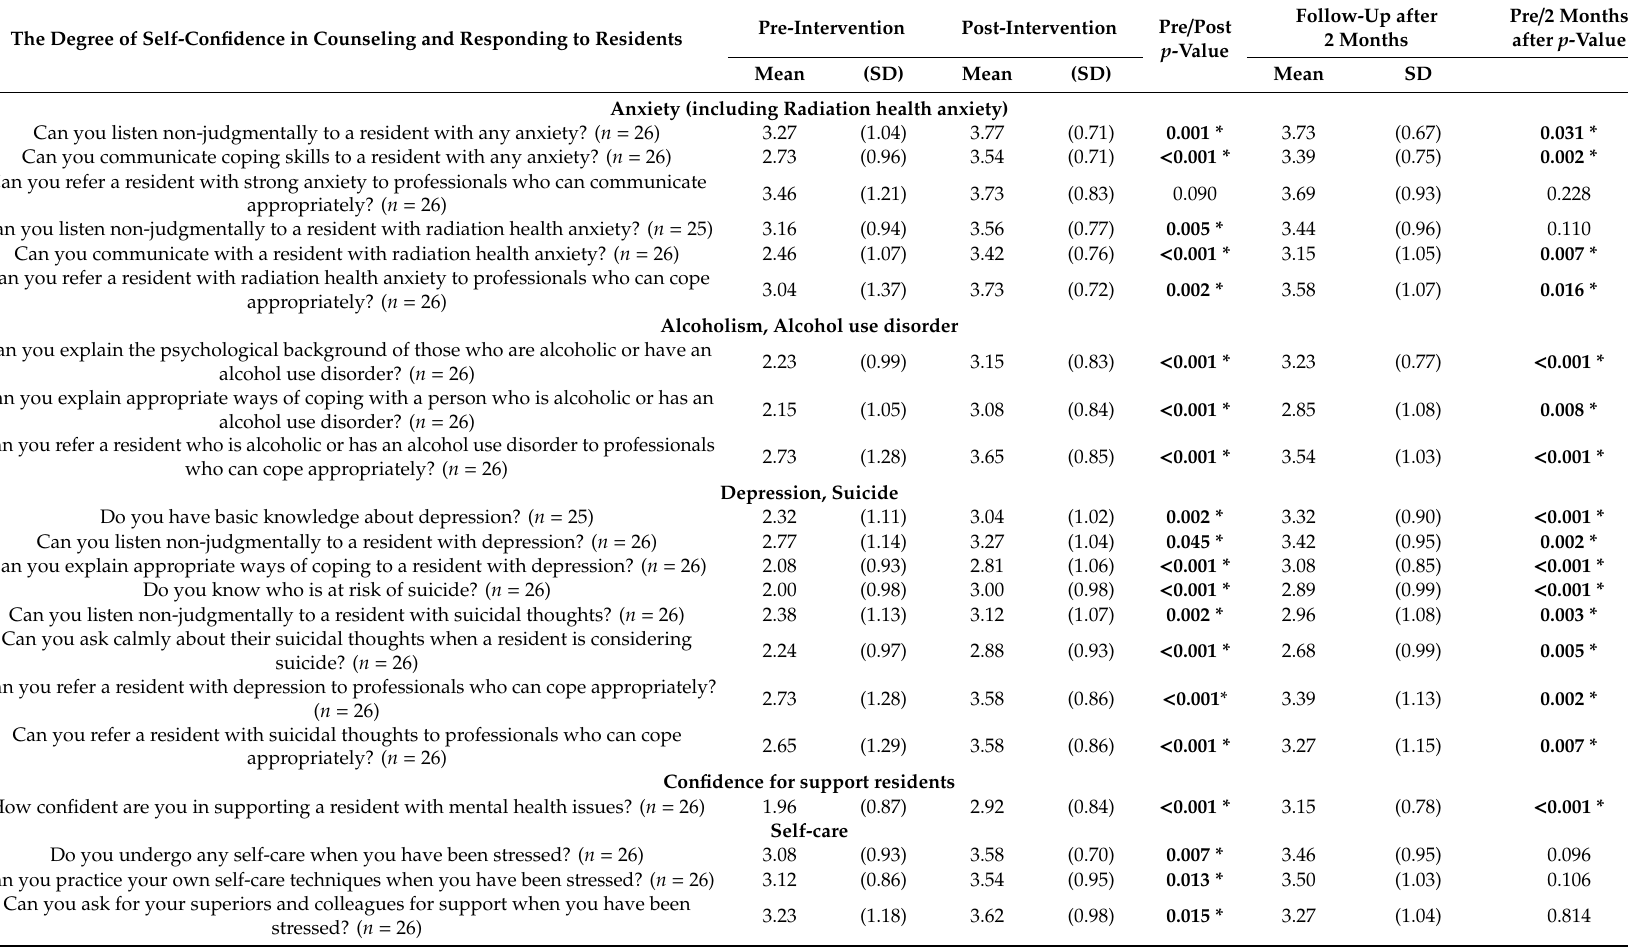
Table 5. Comparison of the degree of self-confidence among the pre-intervention, immediate post-intervention, and 2-month follow-up surveys. The Degree of Self-Confidence in Counseling and Responding to Residents